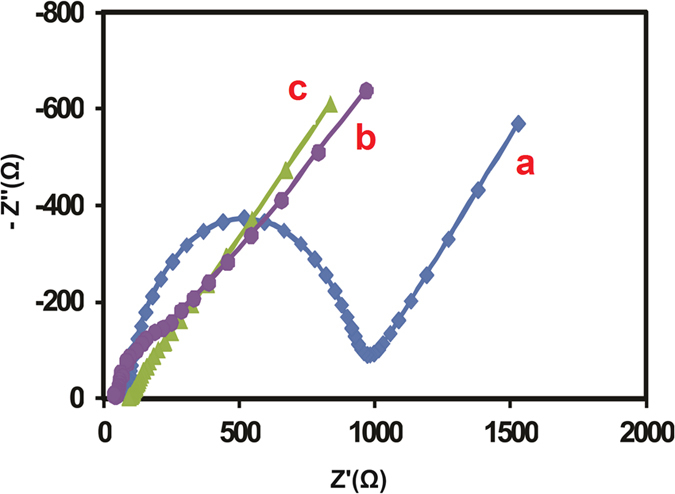
Electrochemical impedance spectra of (a) bare GCE, (b) MCM prepared CeO2 NPs, (c) CRSGM prepared CeO2 NPs in 0.1 M KCl containing 5 mM [Fe(CN)6]3−/4−.